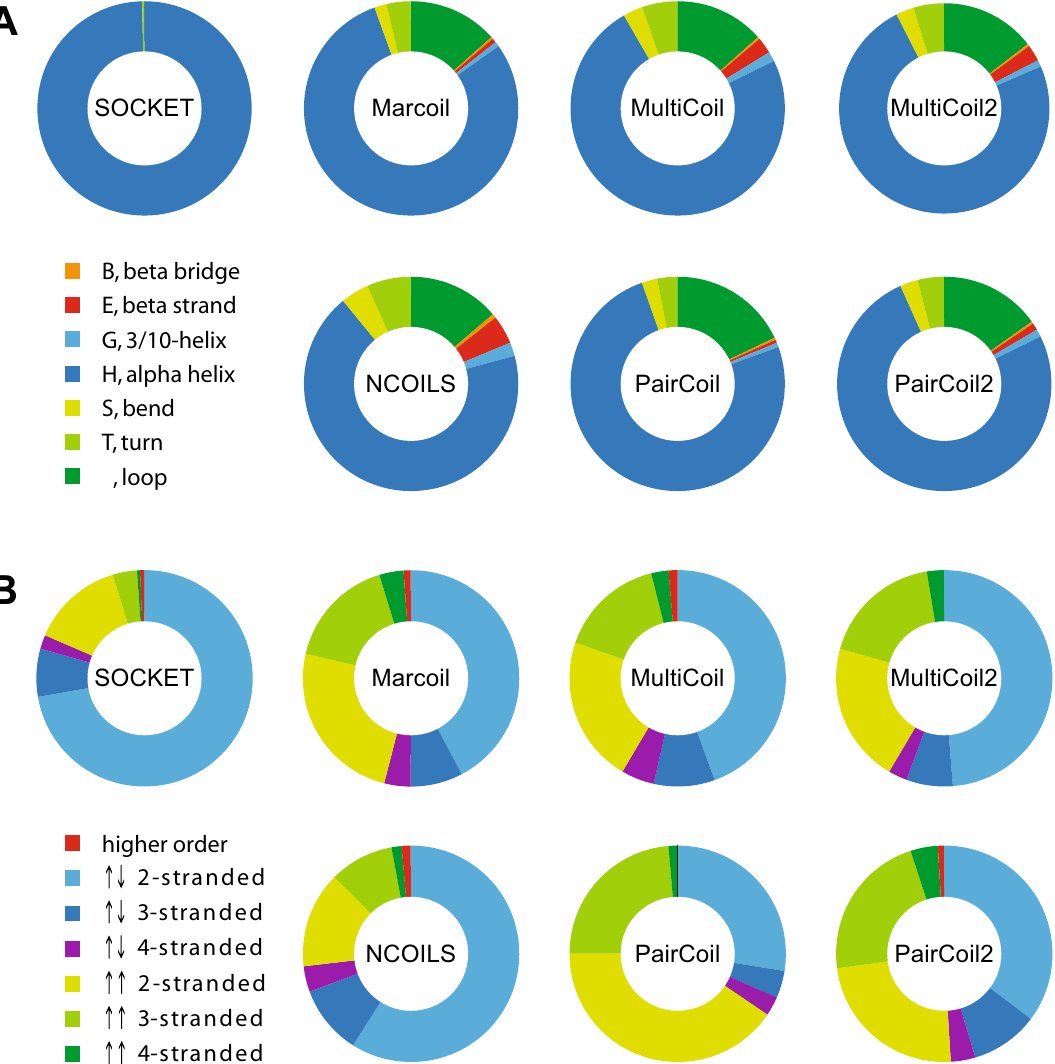
Figure 7. SOCKET hits and coiled-coil predictions matching protein structures. ( A ) The plots represent the matching of all SOCKET hits and all coiled-coil predictions with secondary structure elements as determined by DSSP. The secondary structure assignment for each amino acid was read from the DSSP output, the assignments summed up for each element, and the distribution of elements determined for each tool in percent. ( B ) Coiled- coil predictions on sequence alone are not biased for certain oligomeric states. As reference, the distribution of oligomeric states as determined by SOCKET is shown, with parallel and antiparallel arrangement of the α-helices separated. For each coiled-coil prediction tool, only those predictions were selected that overlap at least 50% of a SOCKET hit, and the oligomeric state assignments of the respective matched hits were